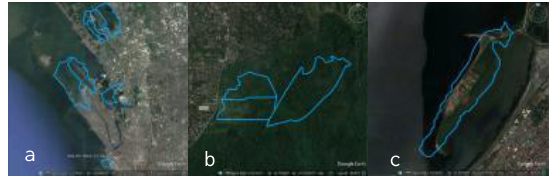
Figure 7. Anti-Intra-Urban Heat Islands (Anti-IUHI’s) in the barangays of (a) Navotas, Malabon, and Valenzuela, (b) Caloocan City, and (c) Las Piñas.